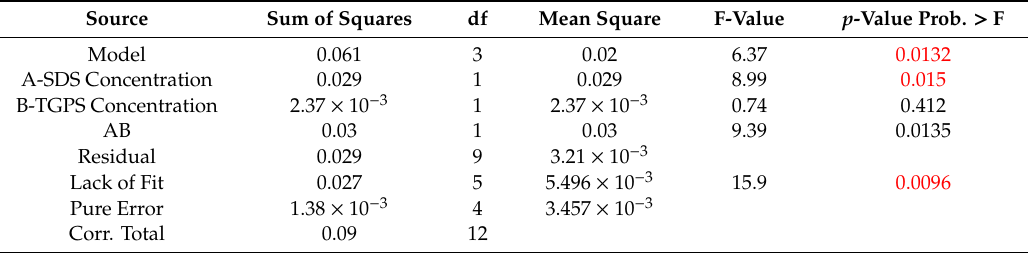
Table 5. ANOVA data for response surface linear model for PDI.